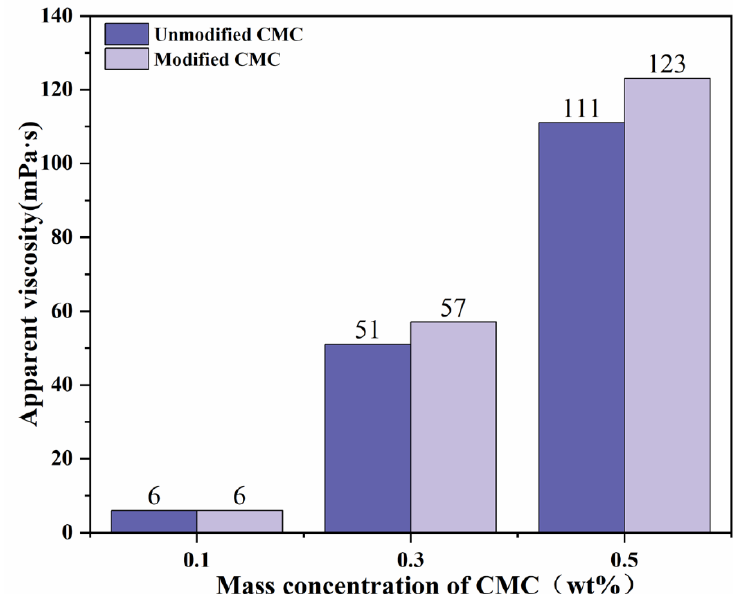
Figure 14. Apparent viscosity of modified CMC and unmodified CMC in 30,000 ppm Na + salinity water.